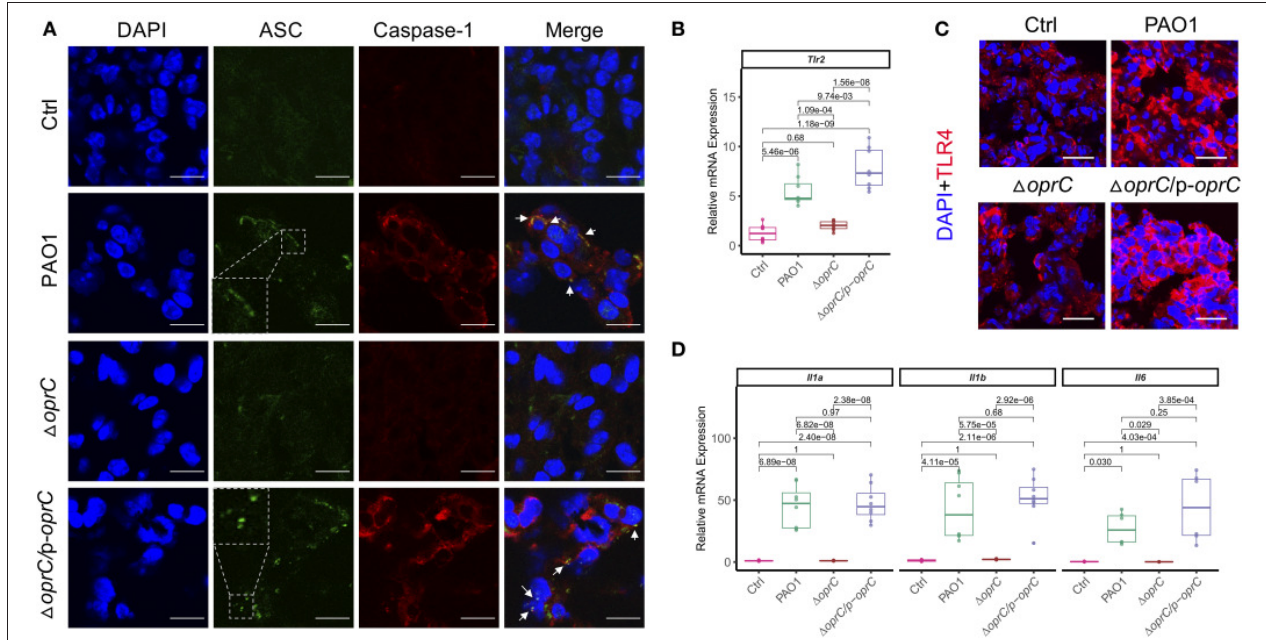
FIGURE 4 | oprC deficiency dampened inflammasome formation and proinflammatory cytokines production upon P. aeruginosa infection. (A) Representative images of immunofluorescence staining of the lungs infected with bacteria for ASC co-stained with caspase-1 and DAPI ( n = 3). Insets indicate the ASC speck-like structures. Arrows show the colocalization between ASC and caspase-1. Scale bars, 10 µ m. (B) The RNAs were isolated from the infected lungs using TRIzol and reverse-transcribed into cDNA. The expression of Tlr2 was assessed by qRT-PCR ( n = 8). (C) Representative images of immunofluorescence staining of the lungs infected with bacteria for TLR4 co-stained with DAPI ( n = 3–5). Scale bars, 20 µ m. (D) The RNAs were isolated from the infected lungs using TRIzol and reverse-transcribed into cDNA. The gene expression levels of Il1a , Il1b , and Il6 were assessed by qRT-PCR ( n = 8). Error bars represent the mean ± s.d. One-way ANOVA with a post-hoc Tukey test was performed for comparison of means of